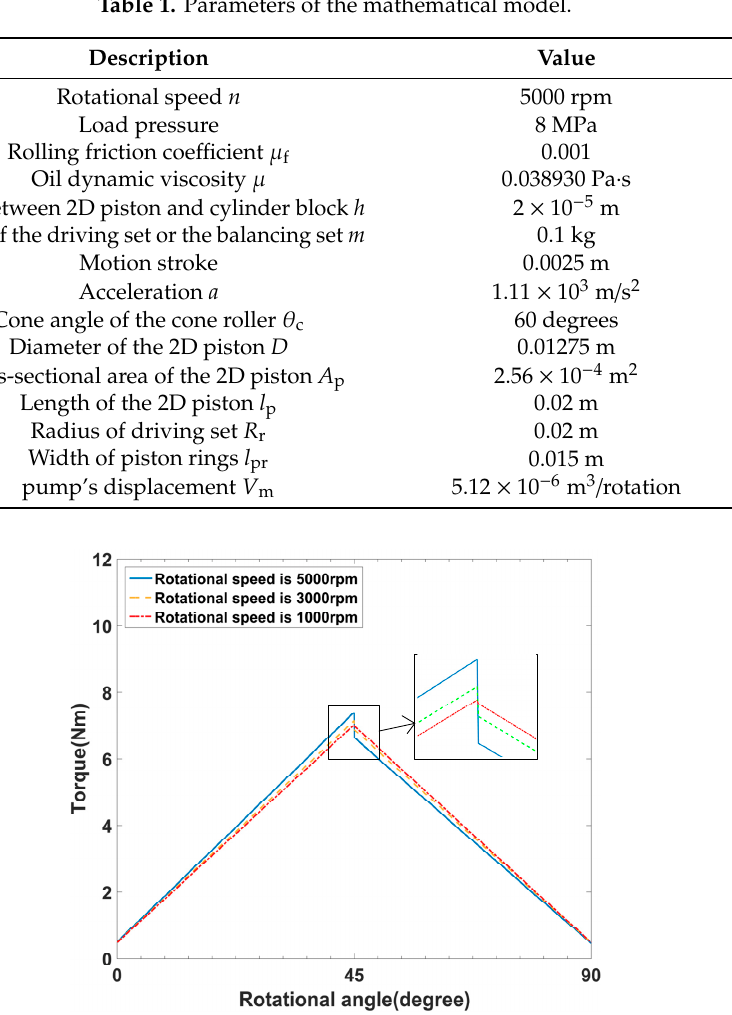
Figure 12. The input torques of the driving set at different masses. The obtained theoretical mechanical efficiencies are shown in Figure 13b with various increasing rotational speeds. It can be obviously observed that the theoretical mechanical efficiency decreased with the increase in the rotational speed. More specifically, as in Figure 13a, the basic mechanical efficiency slightly decreased as the rotational speed increased. Meanwhile, the theoretical mechanical efficiencies with either the viscosity damping or churning loss significantly decreased when the rotational speed was high. The way to minimize the energy loss from the viscosity damping is to enlarge the gap between the piston and the cylinder, which would lead to a larger internal leakage and, thus, a lower volumetric efficiency. However, it is still worthwhile to find an optimized point between the two efficiencies. The energy loss from the churning losses can be relatively easy to handle by carrying an optimization process on the shapes of the driving and balancing sets through CFD numerical calculations.